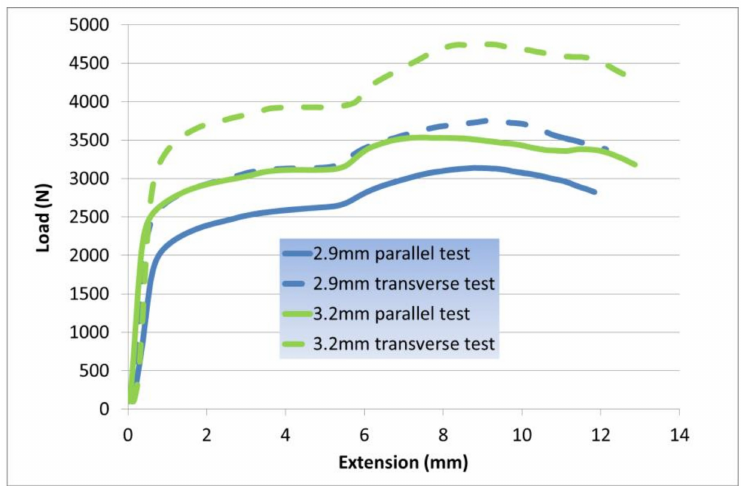
Figure 8. Indicative load—extension curves for longitudinal (solid lines) and transverse (dashed lines) bend tests for 2.9- and 3.2-mm thick samples.